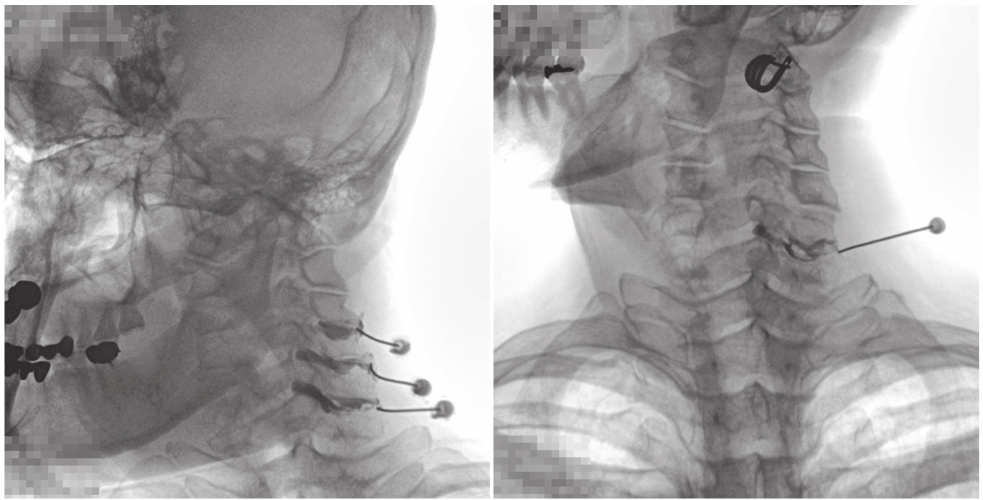
Figure 2. Arthrogram X-ray images showing extra-cervical facet joint